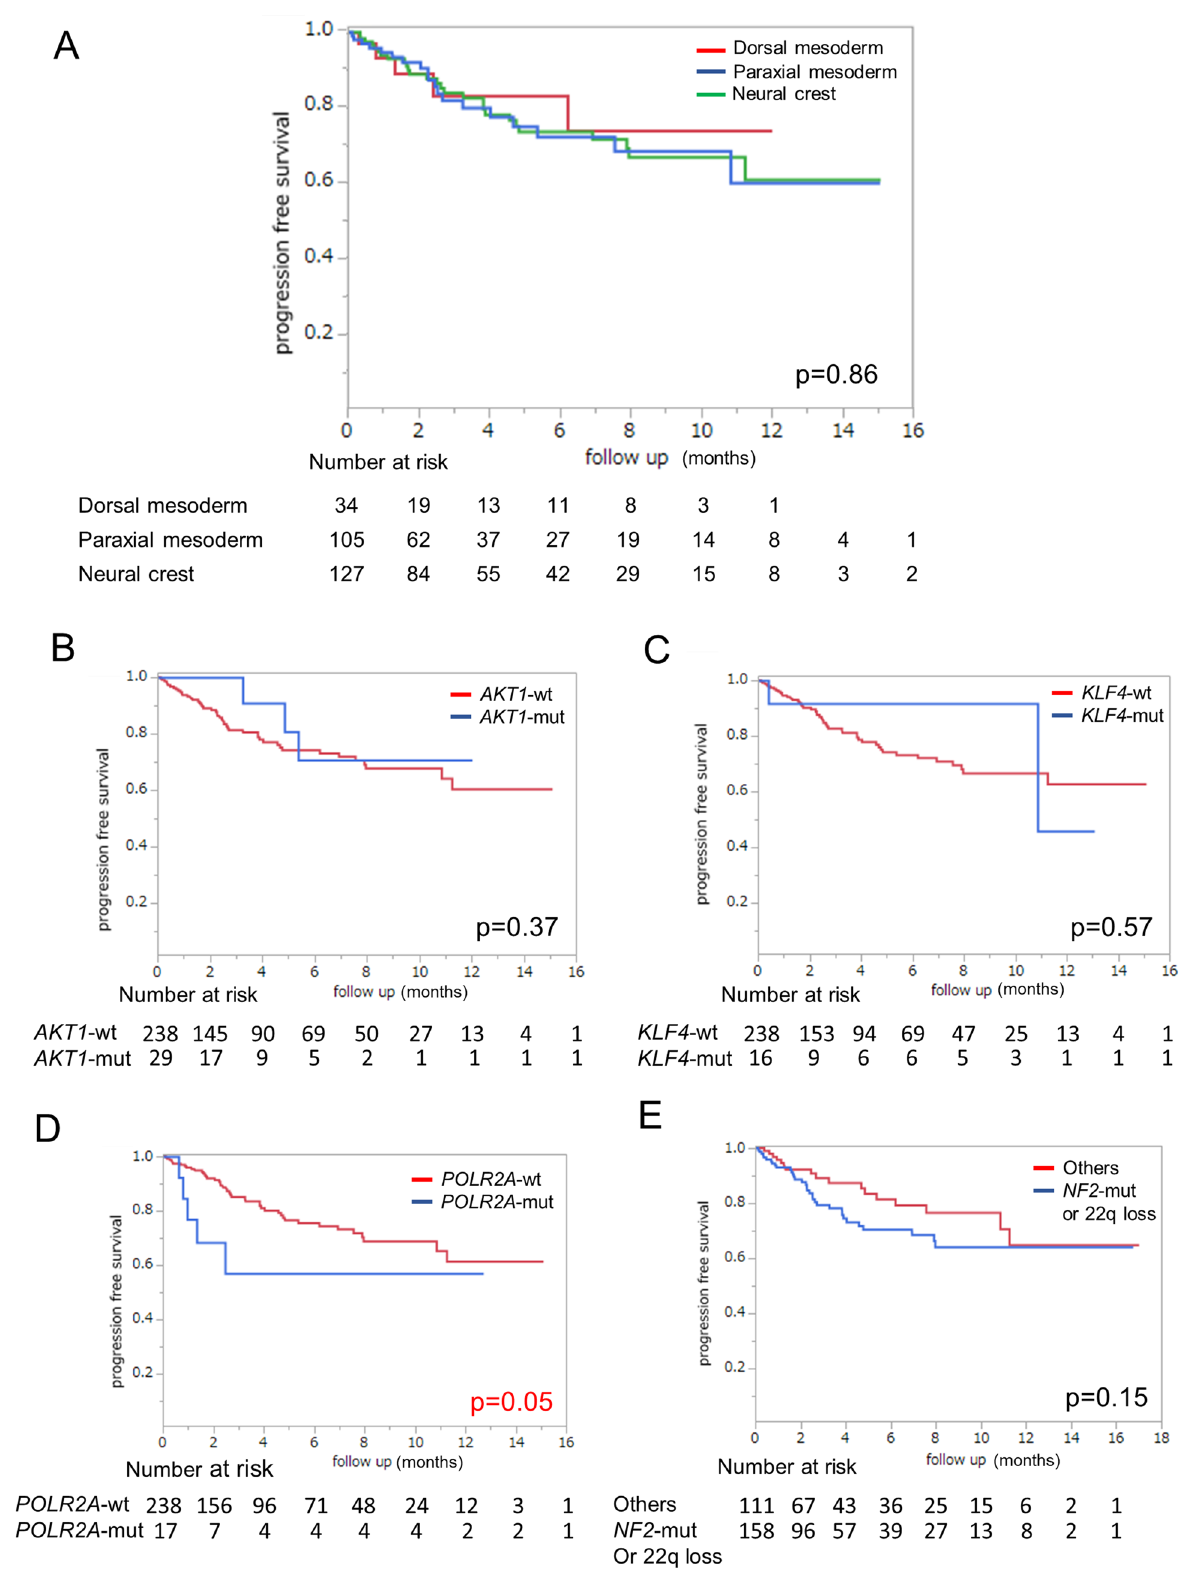
Figure 6. Kaplan–Meier plots of time to recurrence based on genetic mutations. ( A ) Comparison among tumors originating from the dorsal mesoderm, paraxial mesoderm, and neural crest. No significant differences among the three groups ( p = 0.86). ( B ) Comparison between AKT1 mutant and AKT1 wild type. No significant difference between the two groups ( p = 0.37). ( C ) Comparison between KLF4 mutant and KLF4 wild type. No significant difference between the two groups ( p = 0.57). ( D ) Comparison between POLR2A mutant and POLR2A wild type. Progression-free survival was significantly worse among patients harboring mutant than wild type POLR2A ( p = 0.05). ( E ) Comparison between NF2 mutant or 22q loss and other mutation types. No significant difference between the two groups ( p =